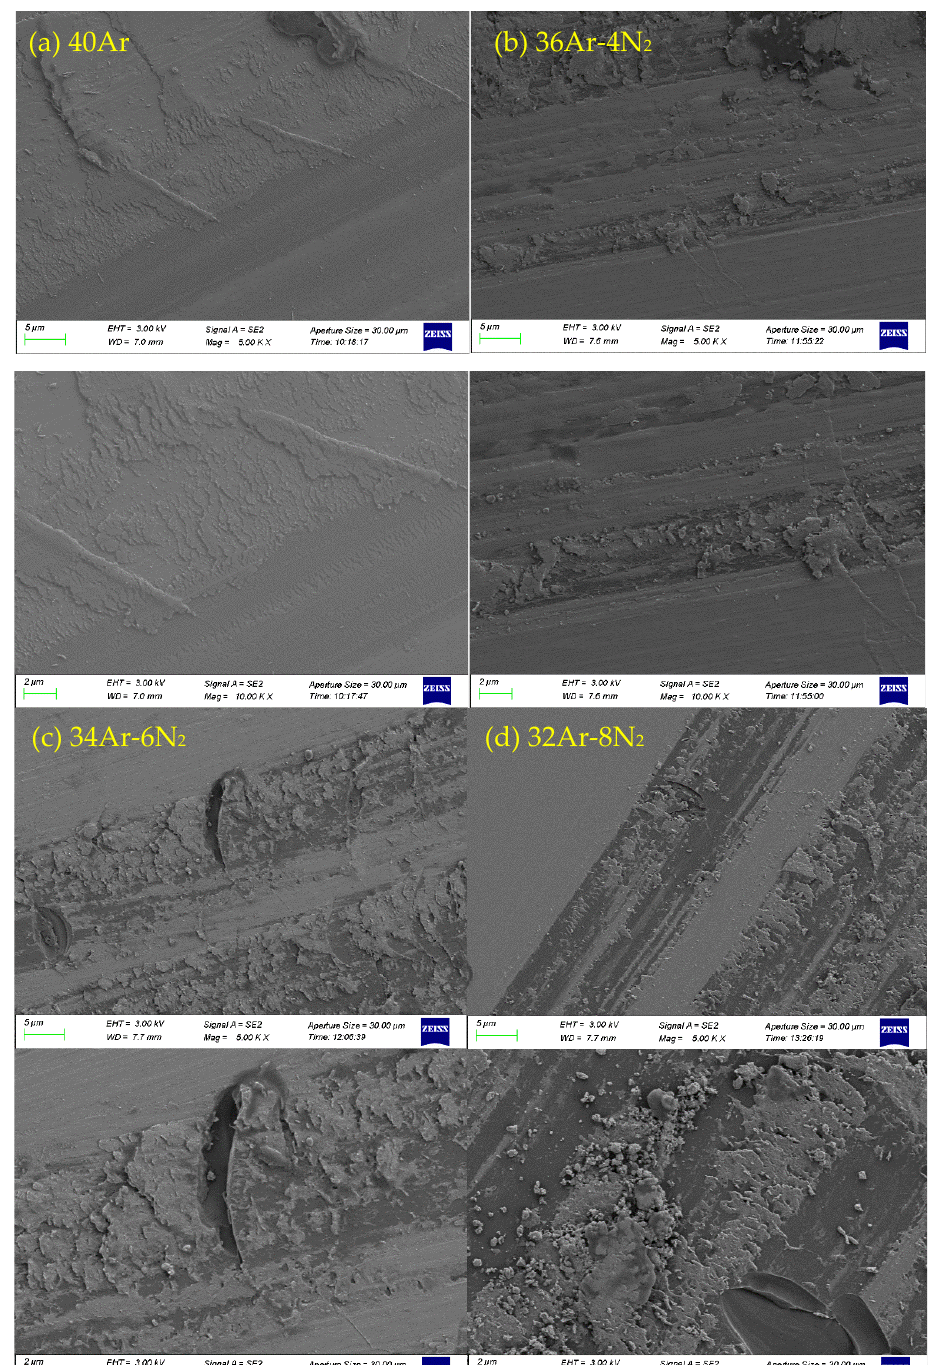
Figure 8. SEM images of wear scar morphology of Ta 2 O 5 coatings prepared under different sputtering gas conditions. ( a ) 40Ar, ( b ) 36Ar–4N 2 , ( c ) 34Ar–6N 2 , ( d ) 32Ar–8N 2